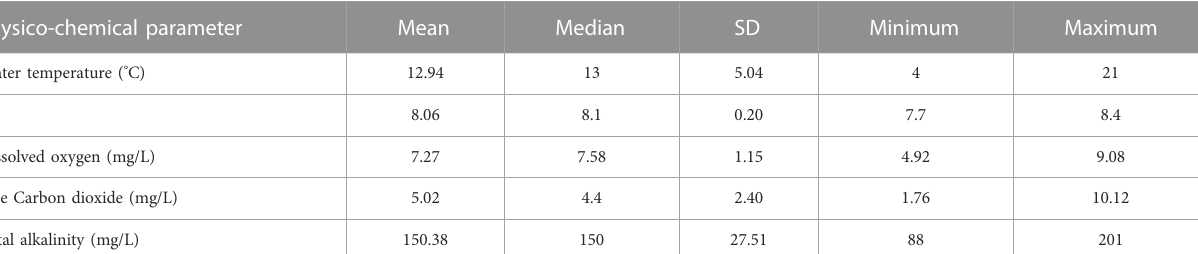
TABLE 1 Physico-chemical parameters of River